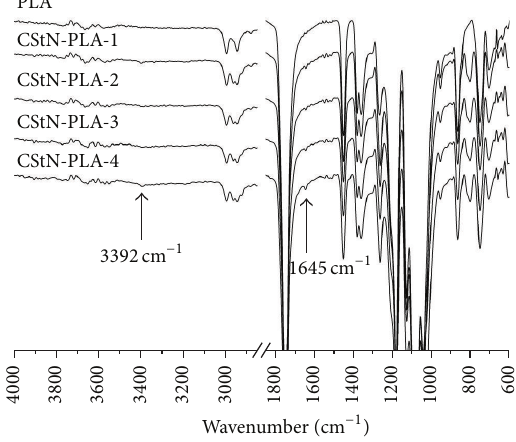
Figure 1: ATR-FTIR spectra of CStN/PLA nanocomposites and PLA films.